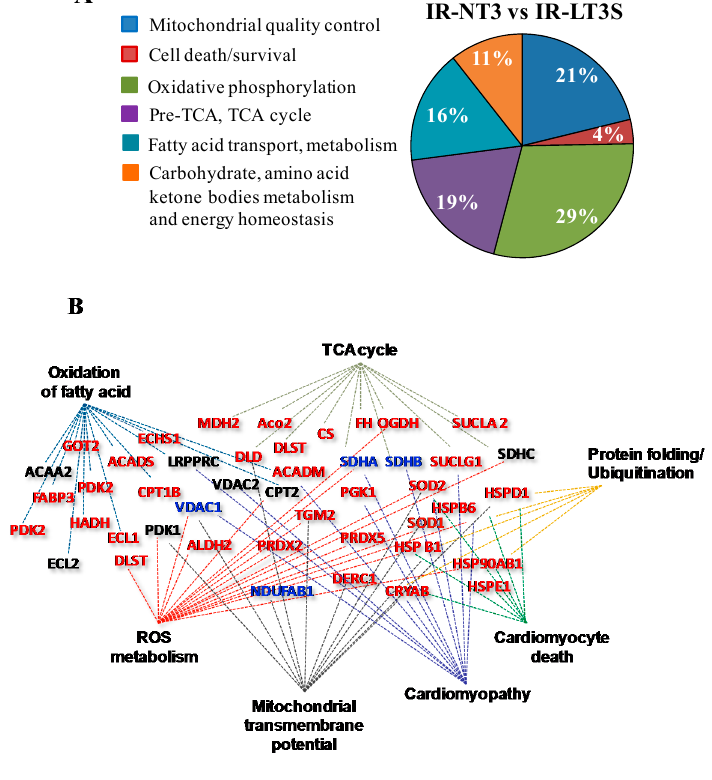
Figure 2. Mitochondrial proteomic analysis obtained at 72 h post IR. ( A ) Pie chart showing percentage of differentially expressed proteins grouped according to their function in IR-NT3 vs. IR-LT3; and ( B ) clustering of differentially expressed proteins in IR-LT3S vs. IR-NT3 generated by IPA software. Networks related to diseases, functions and canonical pathways were generated based on the information stored in IPA Knowledge base. Network nodes are named by correspondent Gene Codes. The color assigned to node name indicate the level of proteins expression: red for up-regulated, blue for down-regulated and black for no change in IR-NT3 vs. IR-LT3S respectively. Gene acronyms are listed in the abbreviation list.